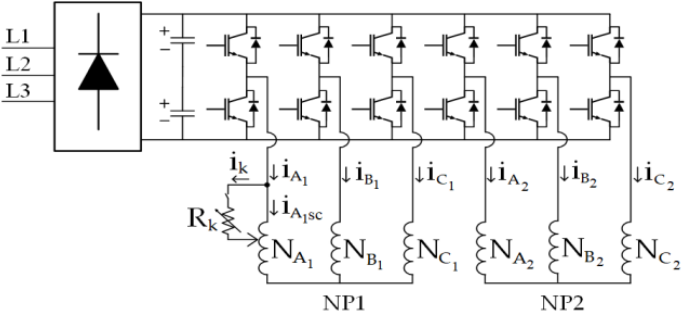
Figure 6. Demonstration of the ITSC fault related to 2NP on the six-phase inverter-fed and ASPIM stator windings.